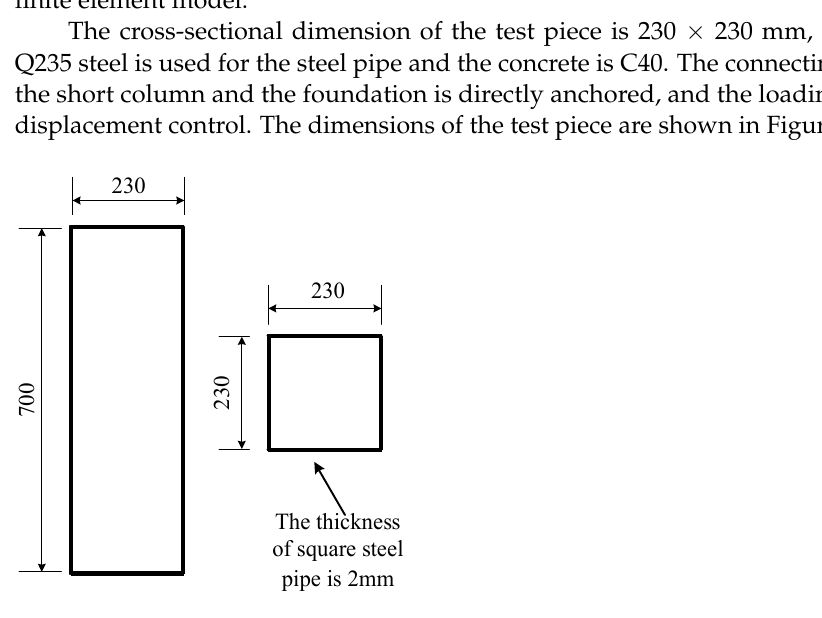
Figure 1. Specimen size of concrete-filled steel tubular column (mm).